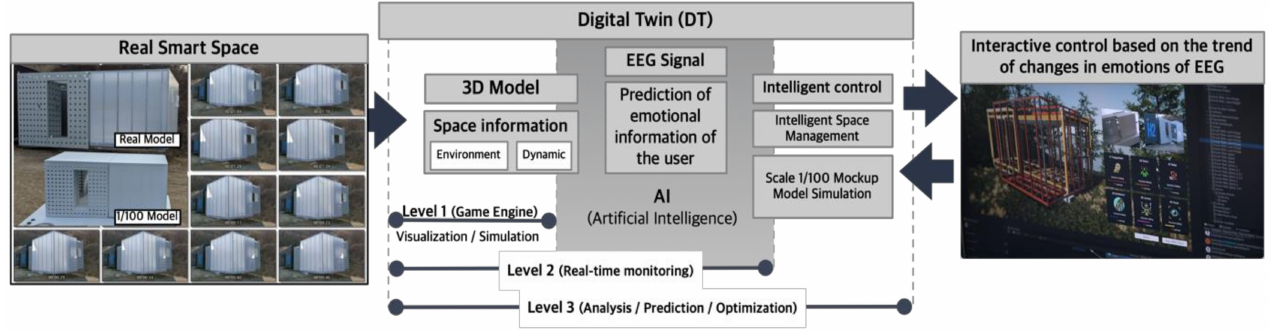
Figure 4. Digital twin (DT) and artificial intelligence (AI) integration